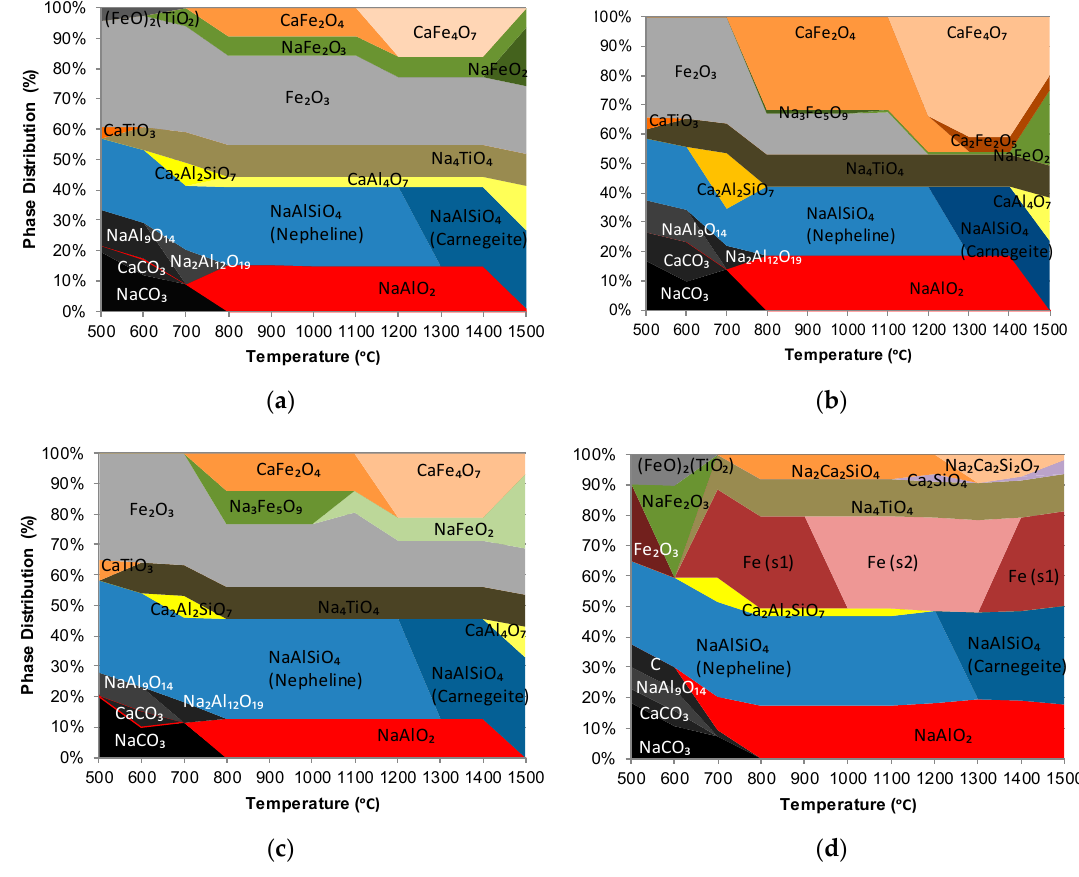
Figure 6. Thermodynamic predictions of sinter phase formations with different representatives of desilication product such as ( a ) Ferrocordierite, Fe 2 Al 4 Si 5 O 18 ( b ) Glossularite, Ca 3 Al 2 Si 3 O 12 ( c ) Albite, NaAlSi 3 O 8 ( d ) Albite, NaAlSi 3 O 8 with 50% excess of soda over stoichiometric amount.